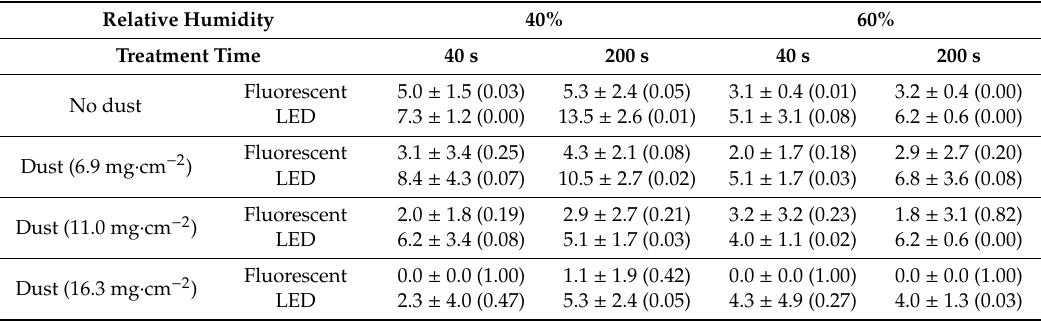
Table A4. NH 3 mitigation under the di ff erent dust levels at a relative humidity of 40% and 60%. Value in the table report % reduction ± standard deviation ( p